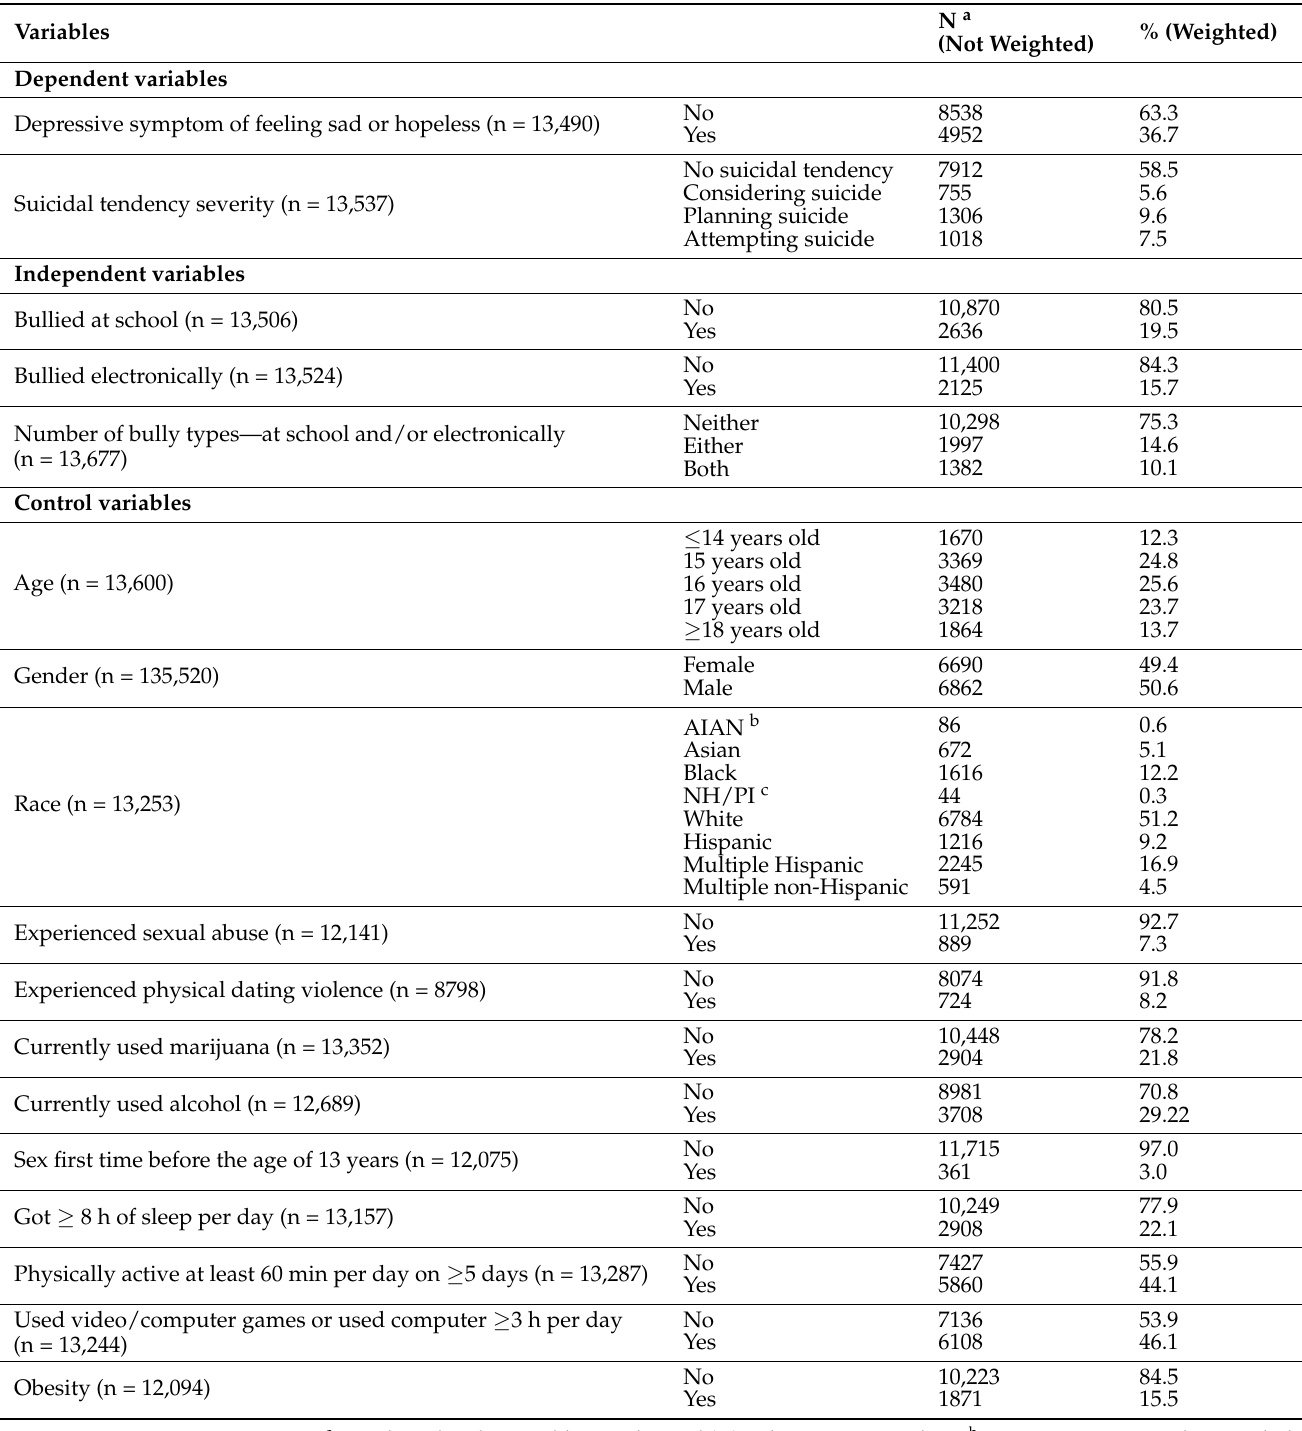
Table 2. Description of dependent, independent, and control variables (N =